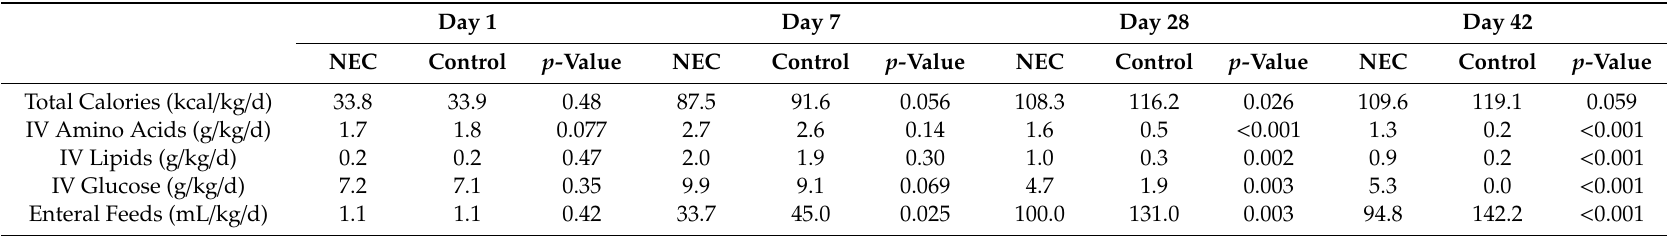
Table 3. Individual time point analysis of nutritional variables using only data obtained before necrotizing enterocolitis (NEC)